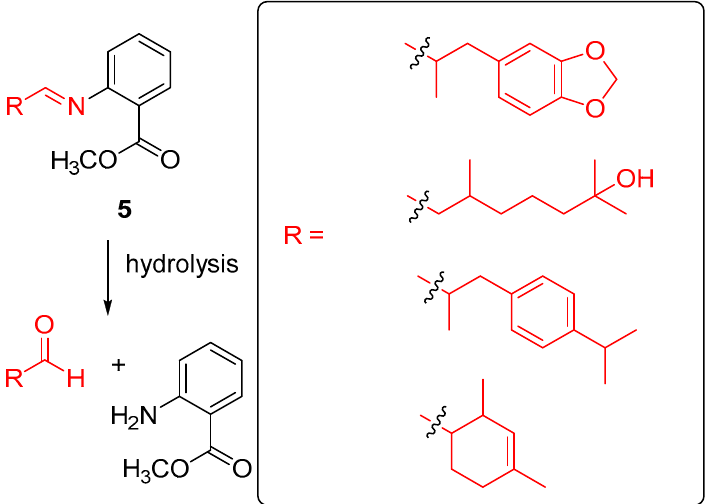
Figure 5. Release of aldehyde-based scents from profragrances 5 , highlighting the aldehyde scent precursor unit. The fragments of the scents are included in a box. The original results were reported by Tomasini, Giuri and coworkers [41].